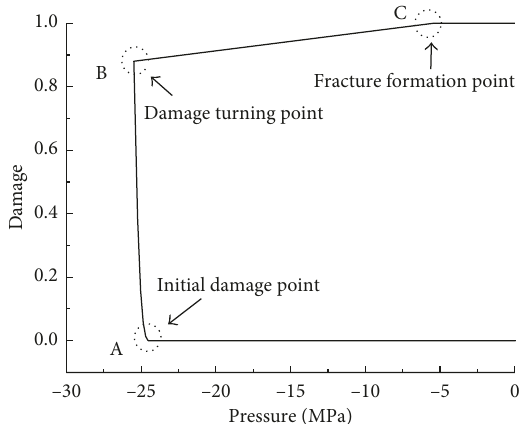
Figure 16: The curve of damage-pressure in the air-filled specimen at 0 ° and L � 20mm.